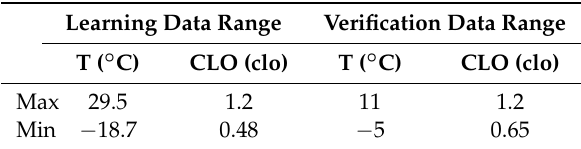
Table 5. Maximum and minimum range of dataset for CLO prediction